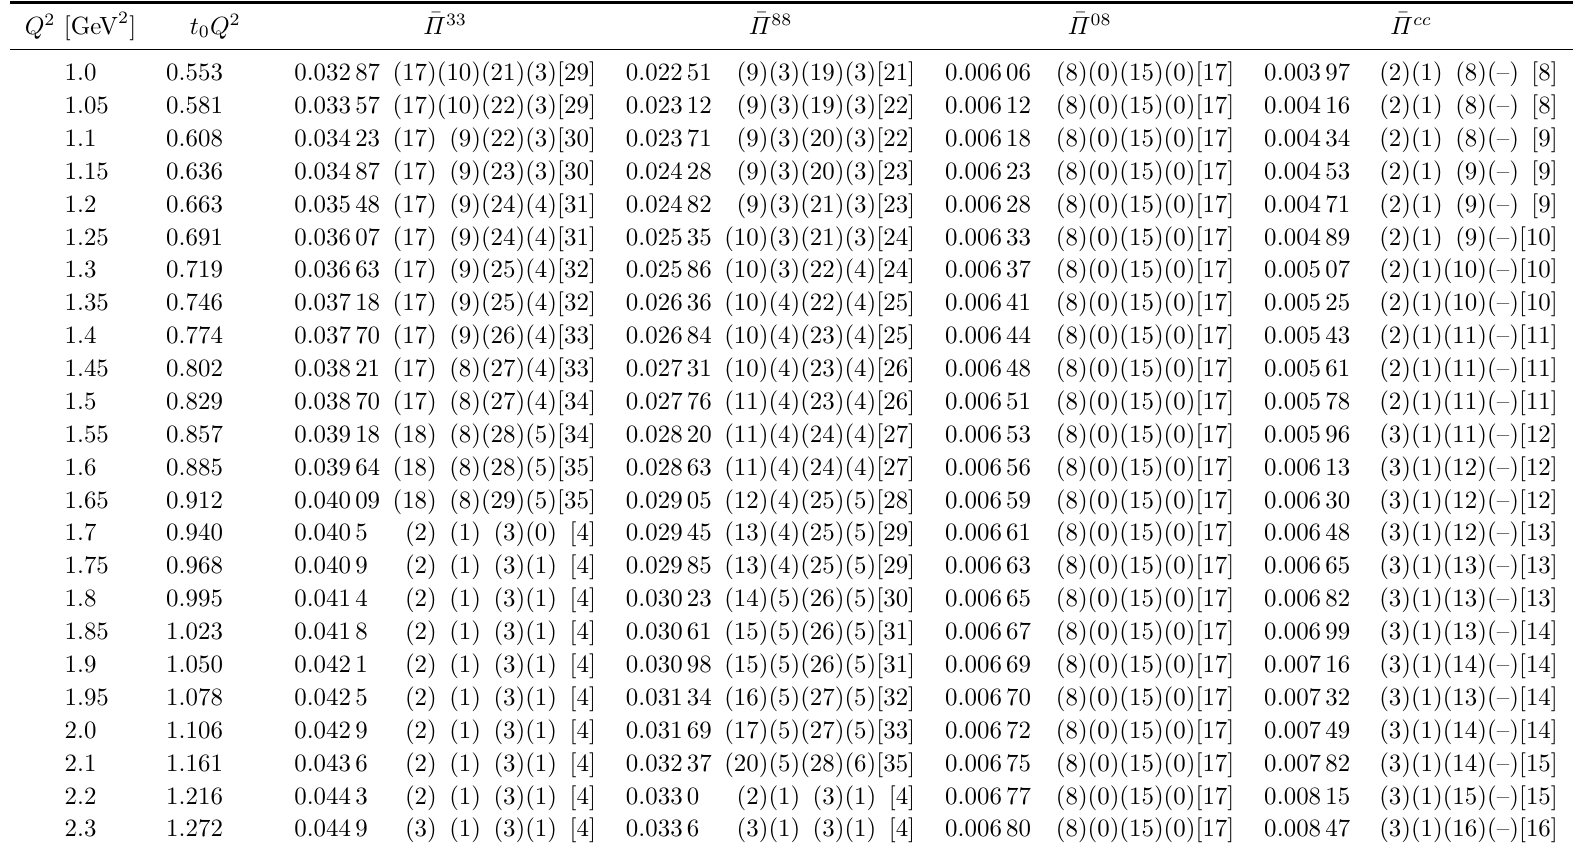
Table 12 . Results for the ¯ Π 33 , ¯ Π 88 , ¯ Π 08 and ¯ Π cc HVP contribution extrapolated to the physical point for all the values of Q 2 sampled. The first quoted uncertainty is the statistical error, the second is the systematic error from varying the fit model estimated in section 4.1.1, the third is the scale-setting error (see section 4.2.1), and the fourth is the systematic from missing charm sea-quark loops (see section 4.2.2). The final uncertainty, quoted in square brackets, is the combination of the previous ones